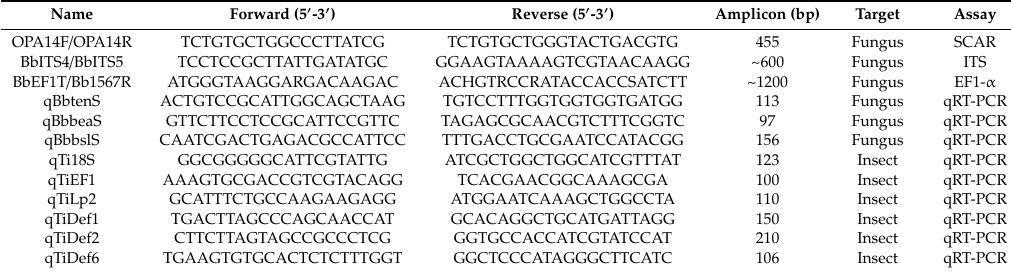
Table 1. Oligonucleotides used in this